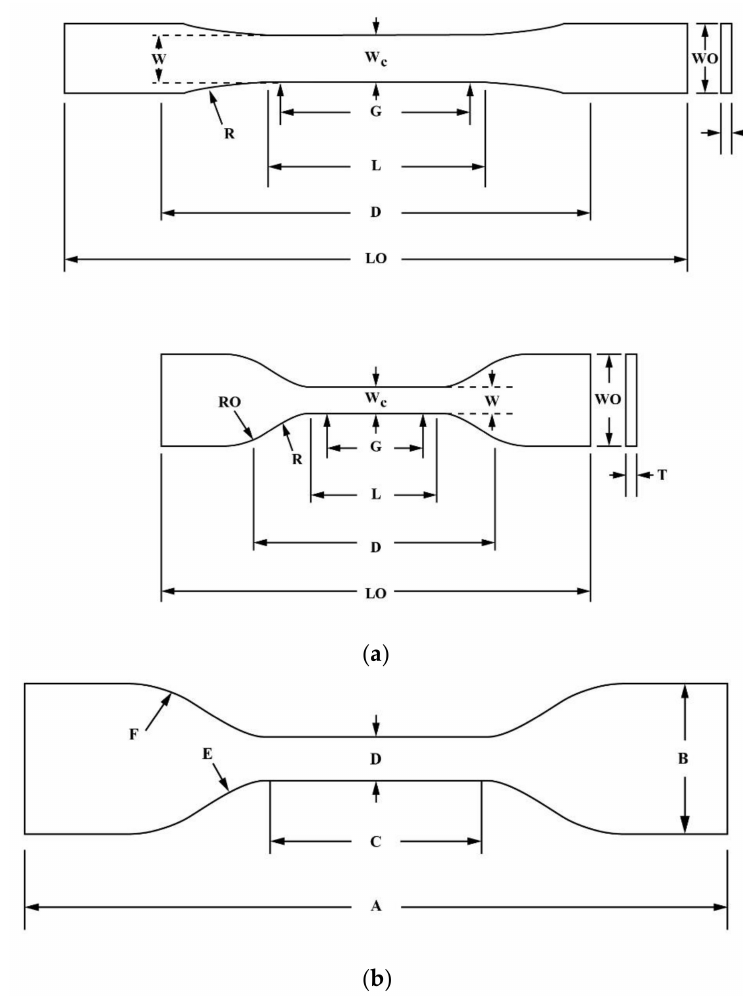
Figure 3. Specimen dimensions for ( a ) ASTM D638 and ( b ) ASTM D412 [36,37].